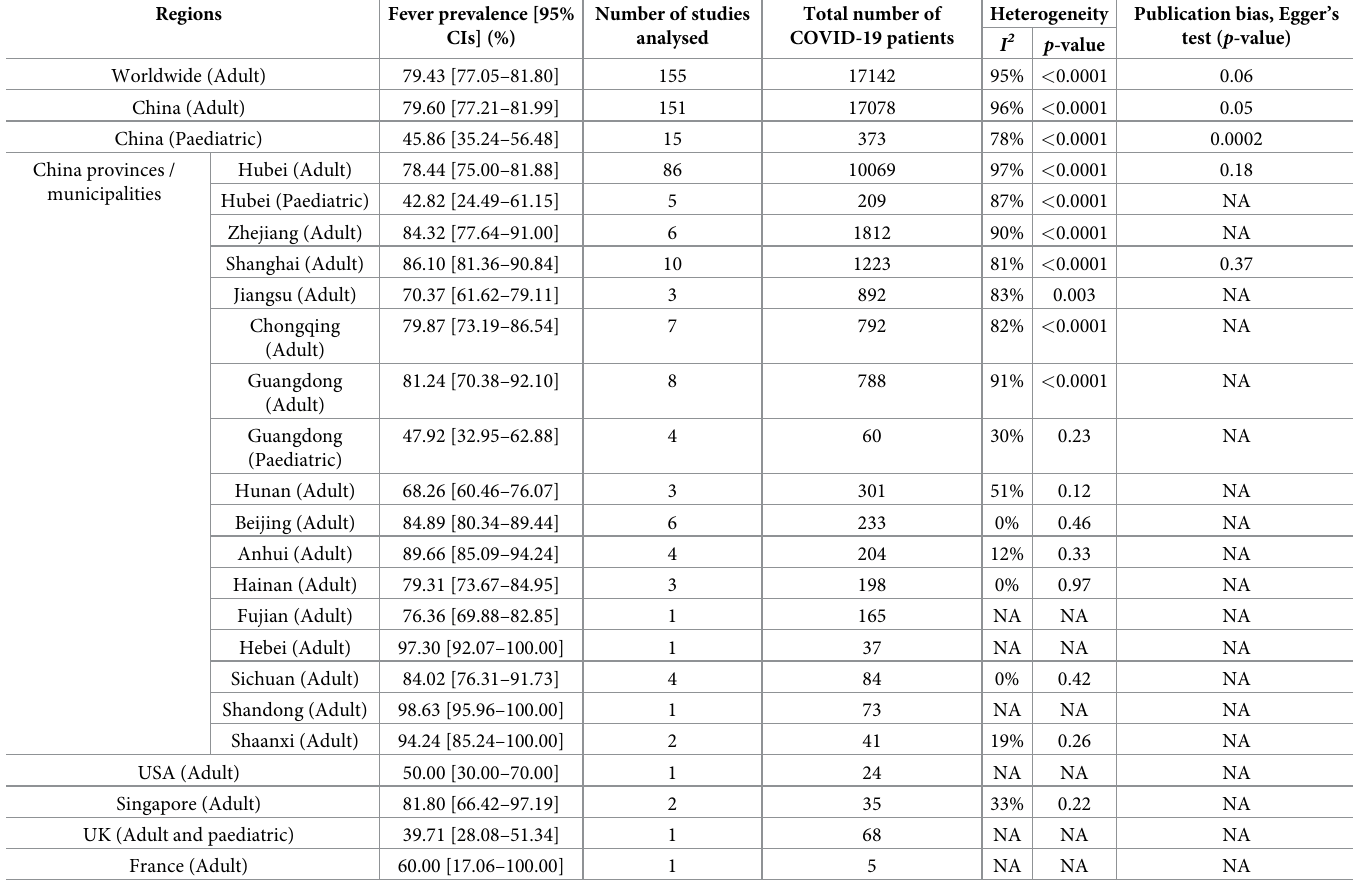
Table 1. Pooled prevalence of fever in COVID-19 patients from different